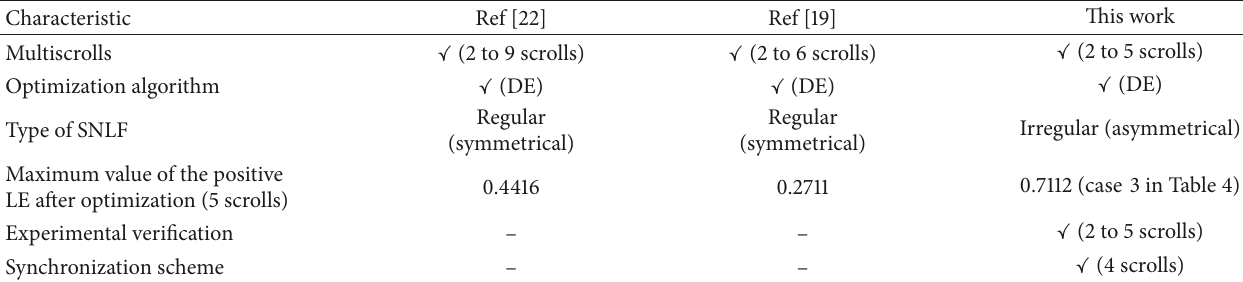
Table 7: Comparison of the main results of this work with other